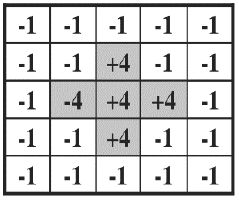
Figure 3. The 5 × 5 mask for focus assessment.